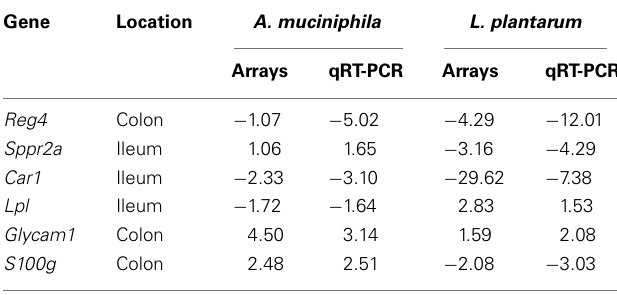
Table 2 | Expression levels of selected genes in intestinal samples from A. muciniphila and L. plantarum mono-associated mice compared to the germ-free